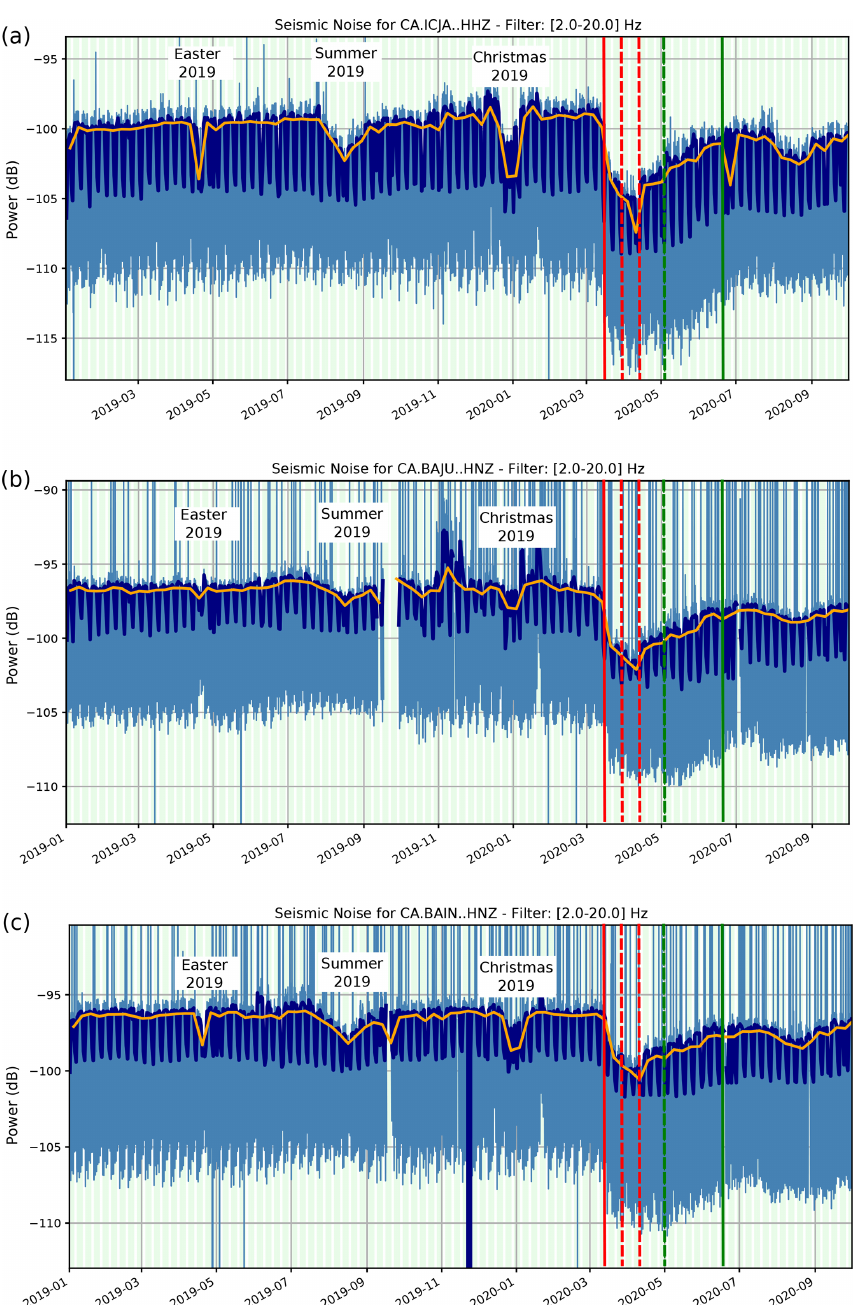
Figure 9. Long-term (1 January 2019–30 September 2020) PSD of the seismic accelerations in the 2–20Hz band. (a) ICJA broadband seismometer. (b) BAJU accelerometer. (c) BAIN accelerometer. Color code as in Fig.